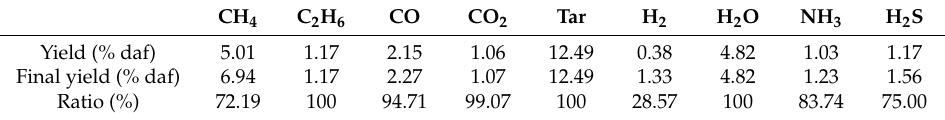
Table 6. Yields of nine components in the volatile matter.